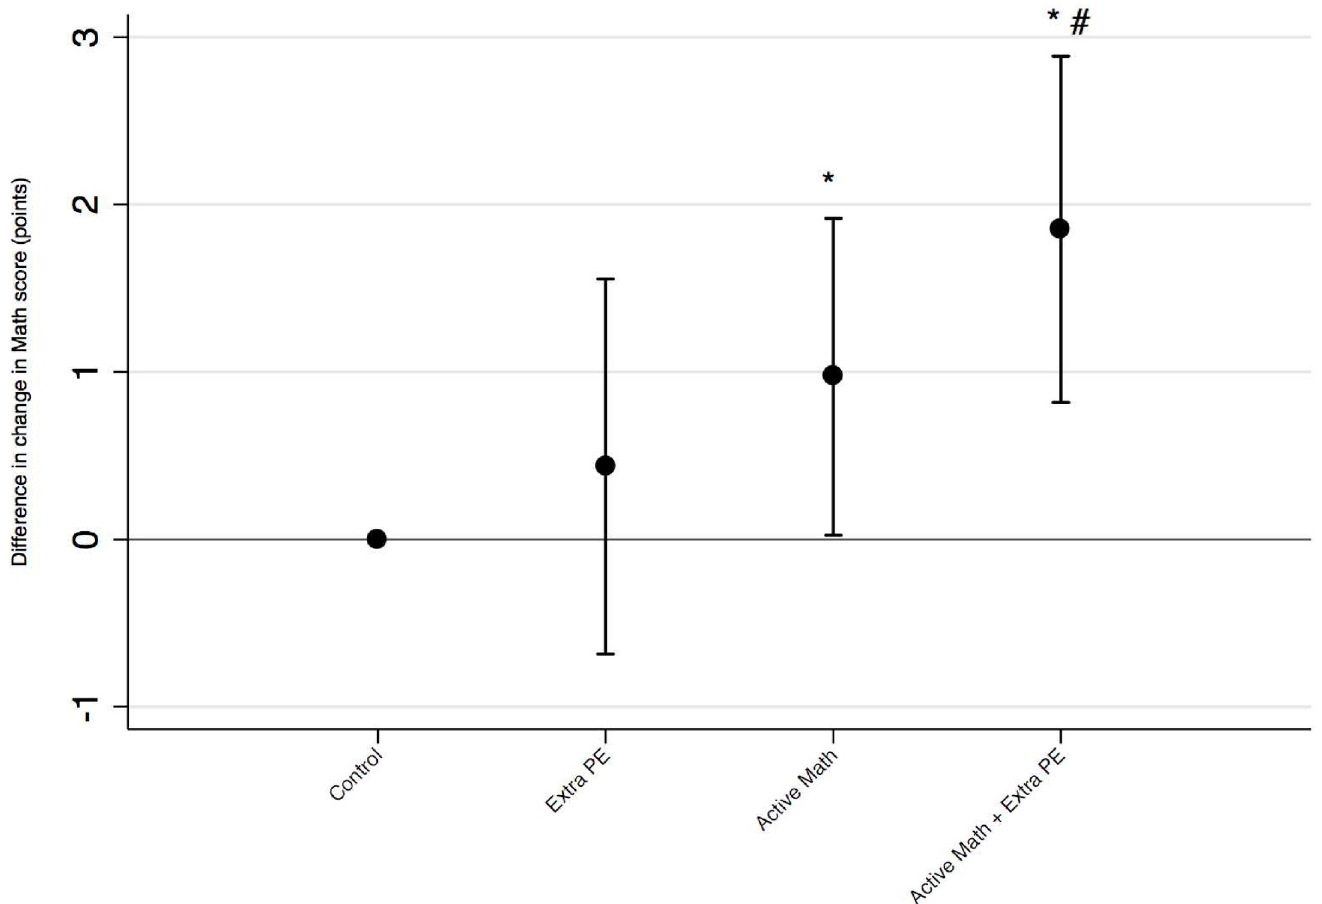
Fig 3. Effect of task-relevant versus general Physical activity. Math score difference in change from control (normal math, 90 min. PE/wk) for subgroups. Extra PE : normal math, 270 min. PE/wk, Active Math : active math, 90 min. PE/wk, Active Math + Extra PE : active math, 270 min. PE/wk. Significantly different from Control: � p < 0.05, Extra PE: # p < 0.05. Data shown as differences in